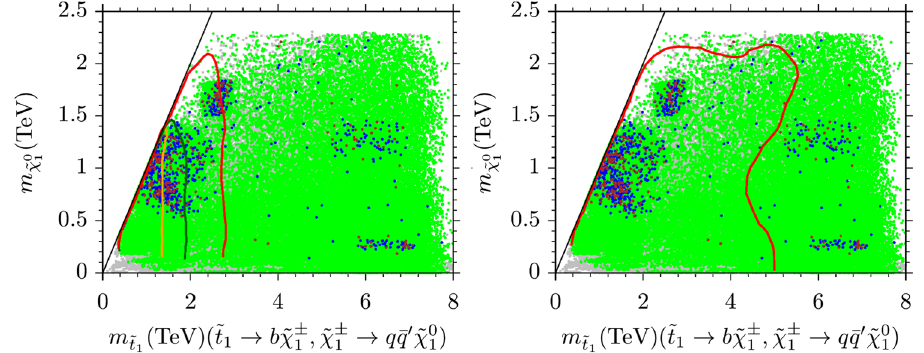
Fig. 9 Exclusion curves for the stop mass through ˜ t 1 → b ˜ χ ± → q ¯ q (cid:3) ˜ χ 0 with ˜ χ ± . The color coding is the same as in Fig. 2. 1 1 In the left panel, orange represents the exclusion at the cur- rent energy, while the dark green and red are obtained at 27